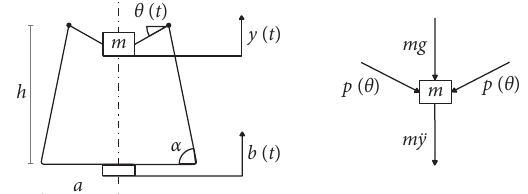
Figure 2: Model of the negative stiffness oscillator and free-body diagram of m